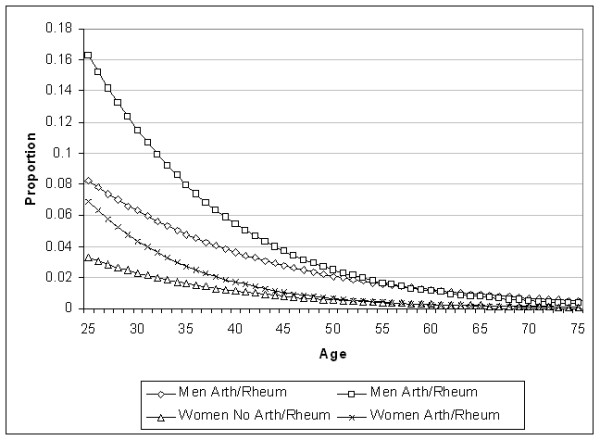
Fitted Proportions: Logistic Regression Model for Substance Dependence. The logistic equation is: -0.98 + 1.37842 (Arth/Rheum) - 0.057 (Age) - 0.56(Sex) - 0.024 (Arth/Rheum by Age) - 0.016 (Age by Sex). Fitted proportions: odds/1 + odds